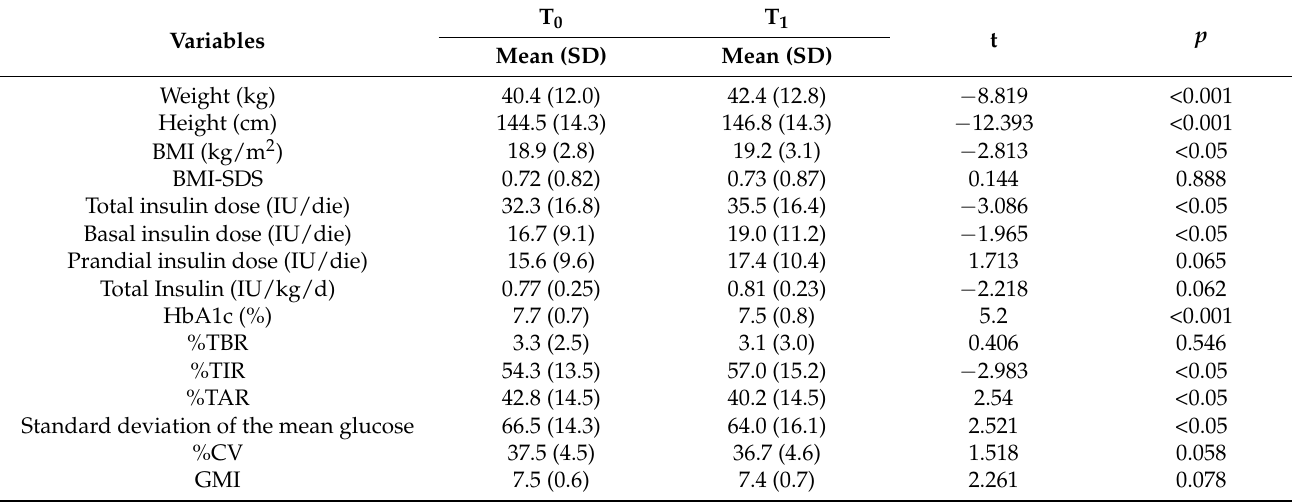
Table 3. Physical characteristics, insulin therapy dose, and glycometabolic variables at the outpatient visit before the COVID-19 lockdown (T 0 ) and at the outpatient visit at the end of the lockdown (T 1